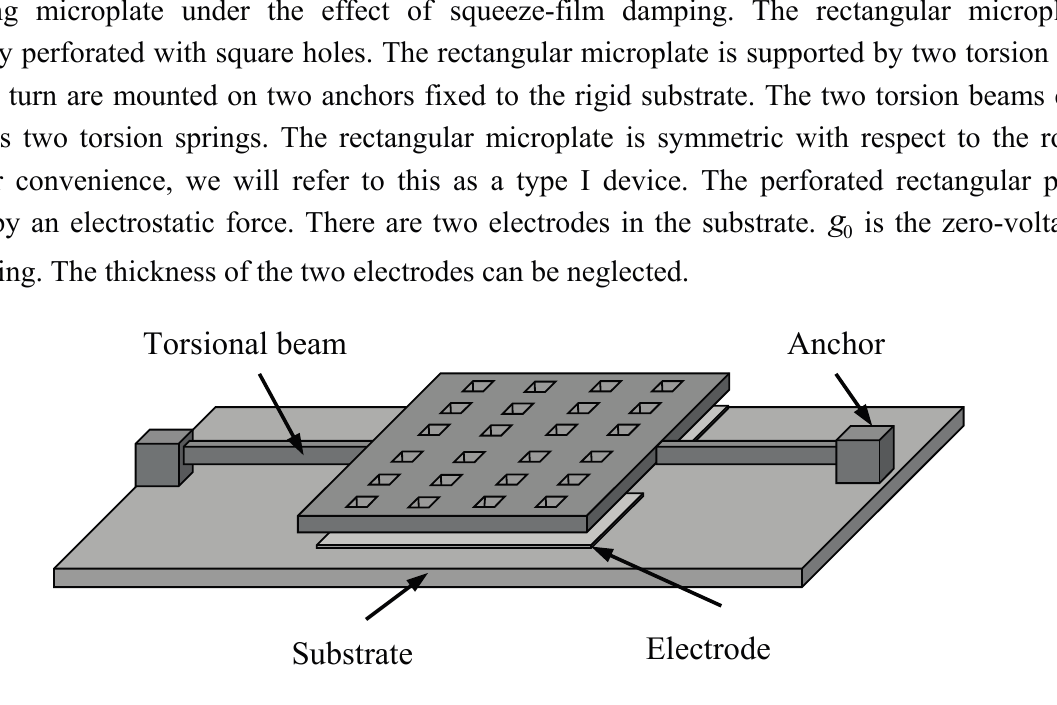
Figure 1. A schematic drawing of a perforated torsion microplate supported by two torsion